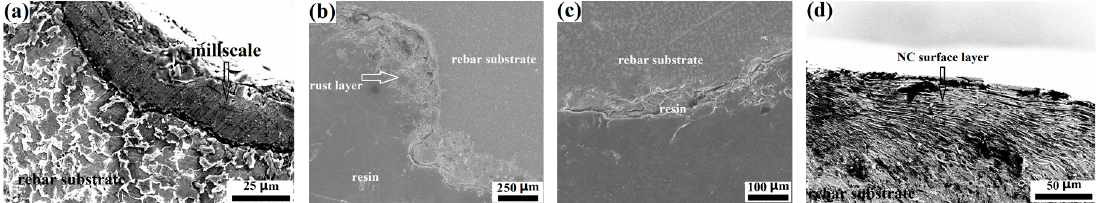
Figure 9. SEM cross-sectional surface microstructures of different rebars: ( a ) as-received, ( b ) rusted, ( c ) sand-blasted, and ( d ) wire-brushed.